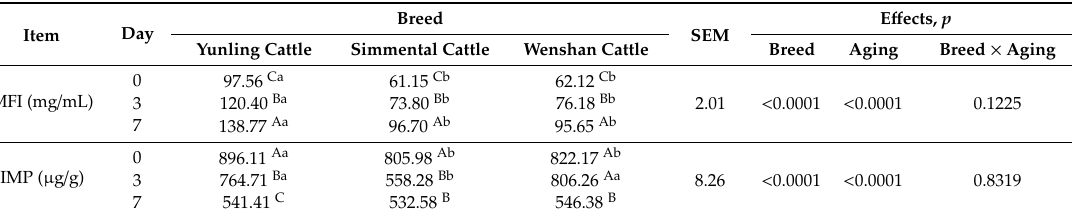
Table 5. The MFI and IMP a ff ected by breed and